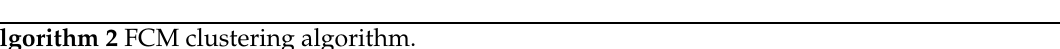
Algorithm 2 FCM clustering